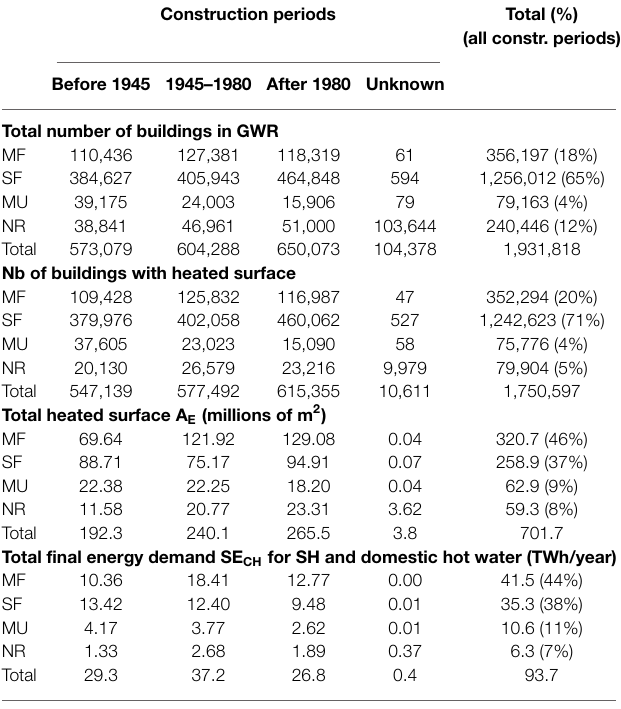
TABLE 2 | Aggregated results of geo-dependent heat demand model. Construction